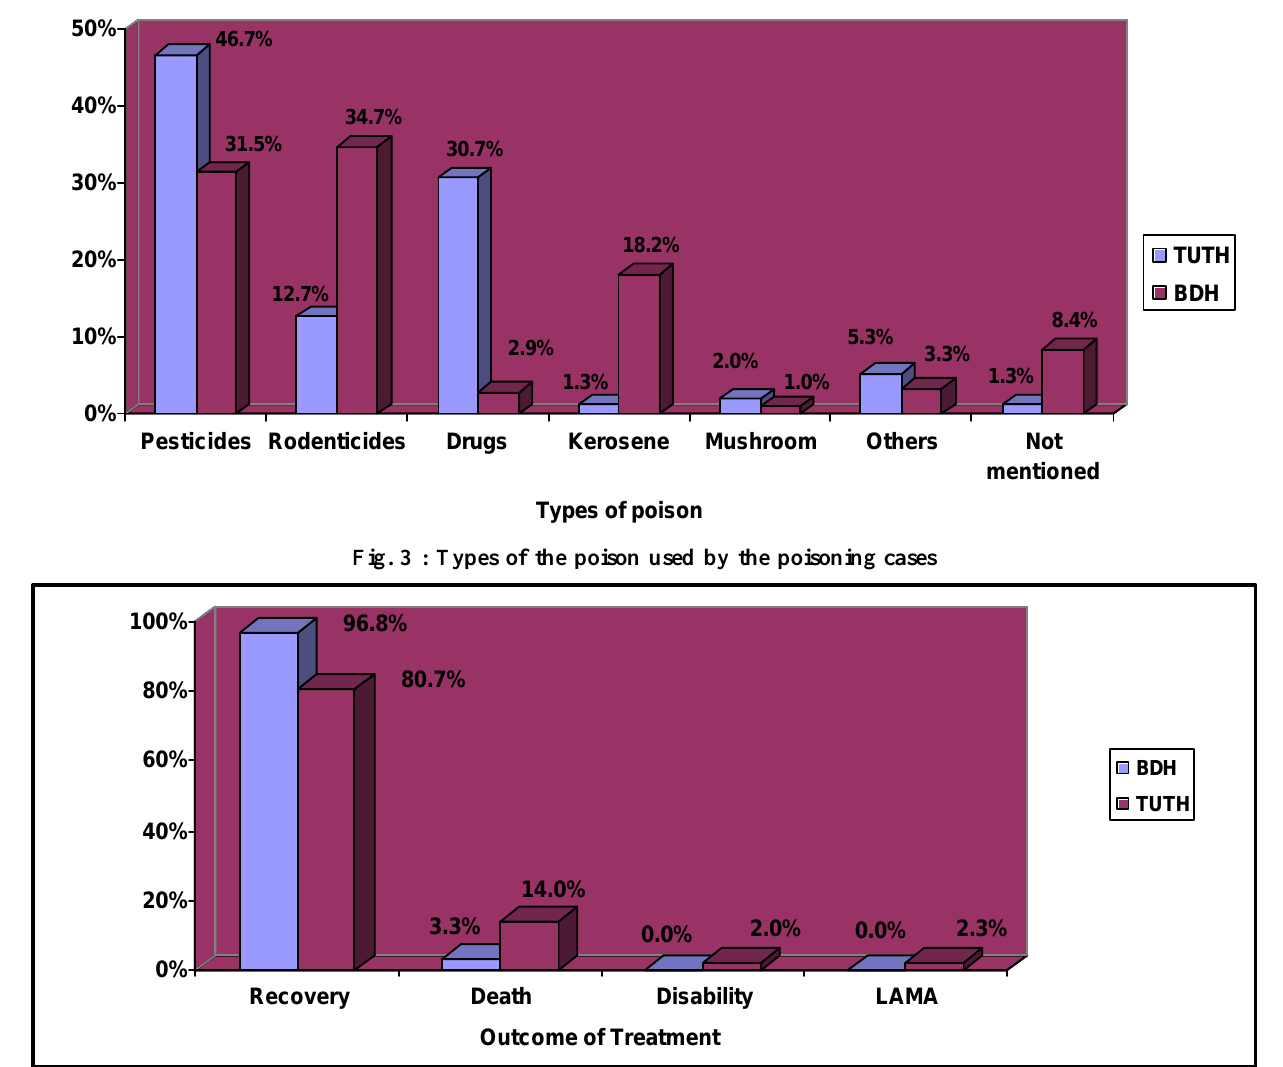
Fig. 4 : Outcome of Treatment of the poisoning cases